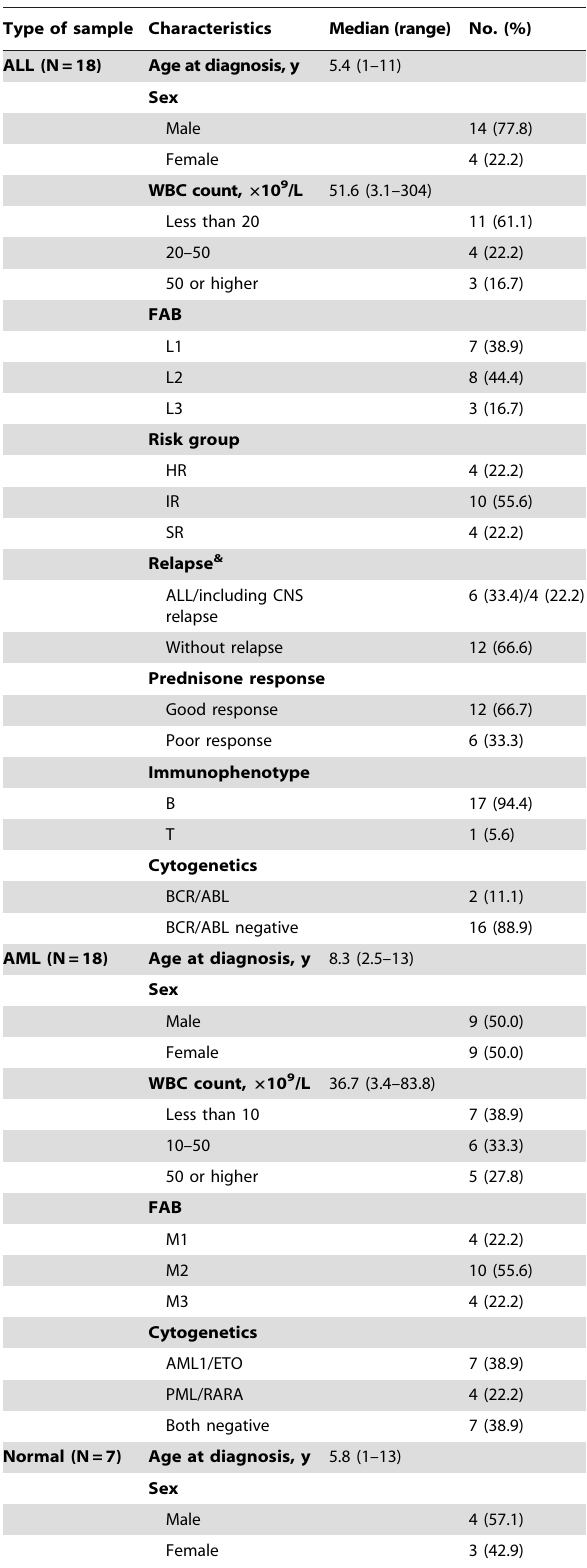
Table 1. Characteristics of test cohort.